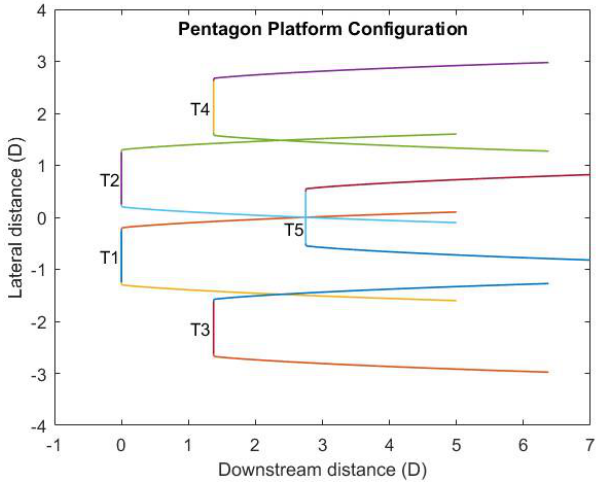
Figure 2. Wake propagation for a pentagon platform.